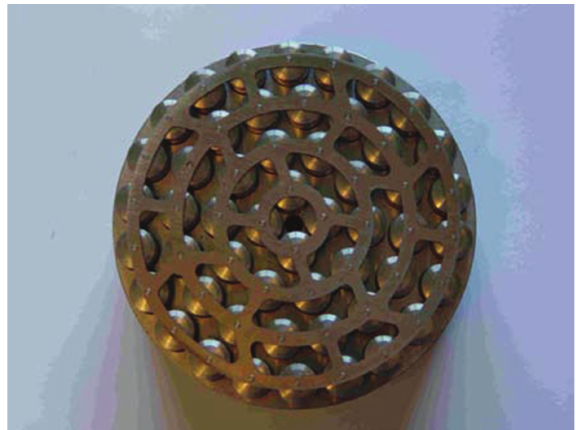
Figure 7: CARA end plate.